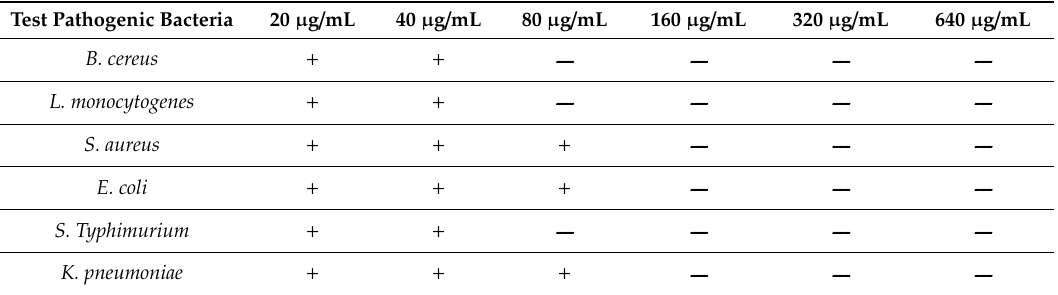
Table 2. Minimum inhibitory concentration (MIC) and minimum bacterial concentration (MBC) of biological nano-Se. (C): colistin only (D): colistin + nano-Se BIO. Test Pathogenic Bacteria